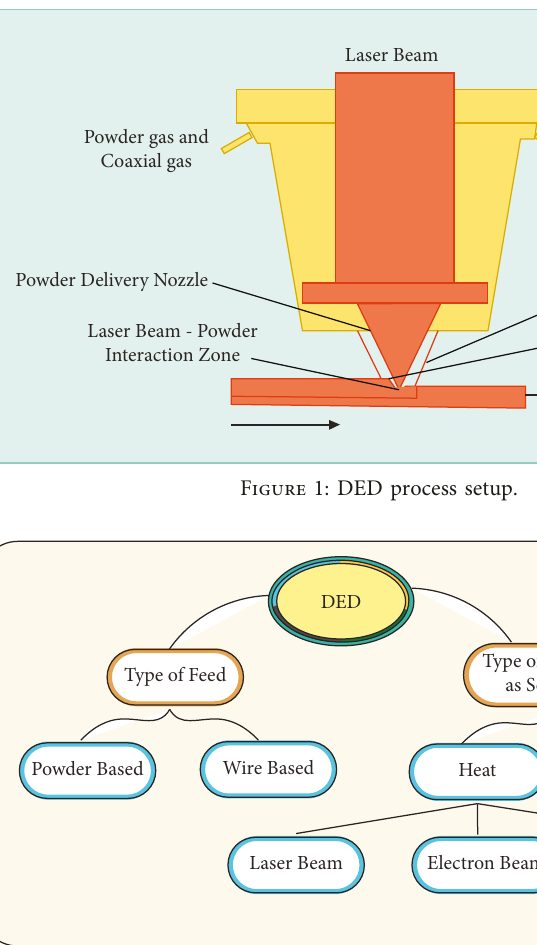
Figure 2: DED classification.